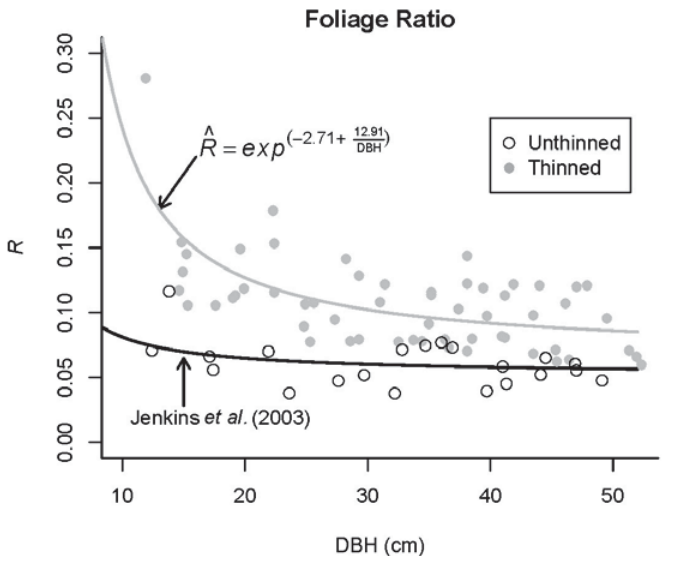
untreated (open circles) with published model [16,32] (black line) and fitted for thinned values (grey